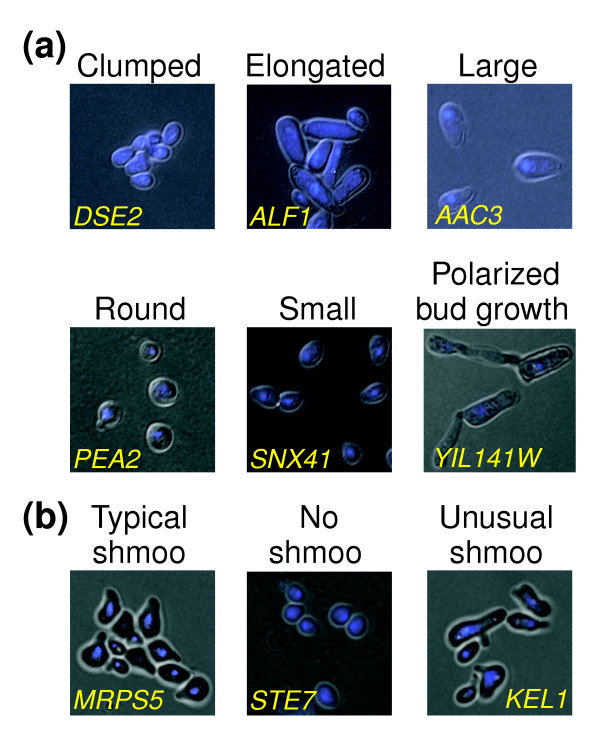
Characteristic yeast cell phenotypes observed on arrays. DIC images from cell chips were collected automatically at 60× magnification with DAPI-stained nuclei superimposed in blue pseudocolor. Each gene name indicates the corresponding deletion strain (for example, dse2 ΔKanMX4 ). (a) Six phenotypic classes observed among the haploid yeast deletion strains. YIL141W overlaps the AXL2 gene, whose disruption in the deletion strain probably provides the observed morphology. (b) Changes in cell morphology observed after treating the deletion collection with mating pheromone. Many mutants, such as the mrps5 ΔKanMX4 deletion strain (left), form 'wild-type'-like mating projections upon adding alpha factor, while cells lacking STE7 (middle) fail to form mating projections, and cells lacking KEL1 (right) form mating projections of unusual morphology.